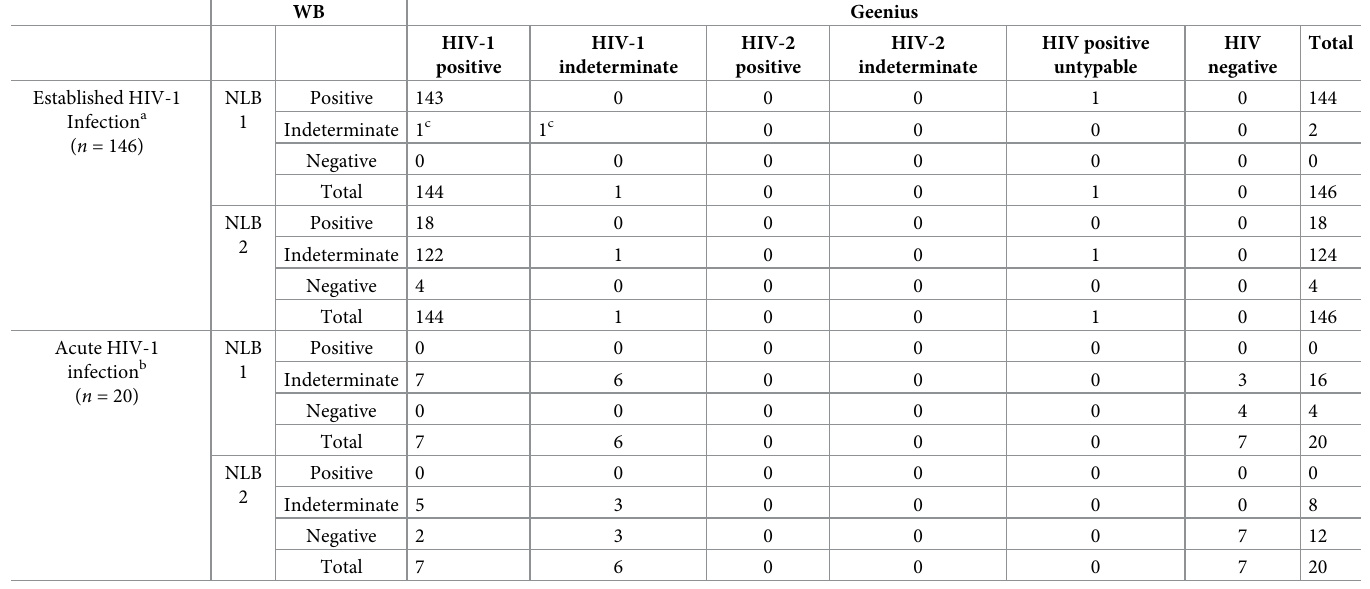
Table 1. Comparison of Geenius with NLB 1 and 2 results for established and acute HIV-1 infection samples.